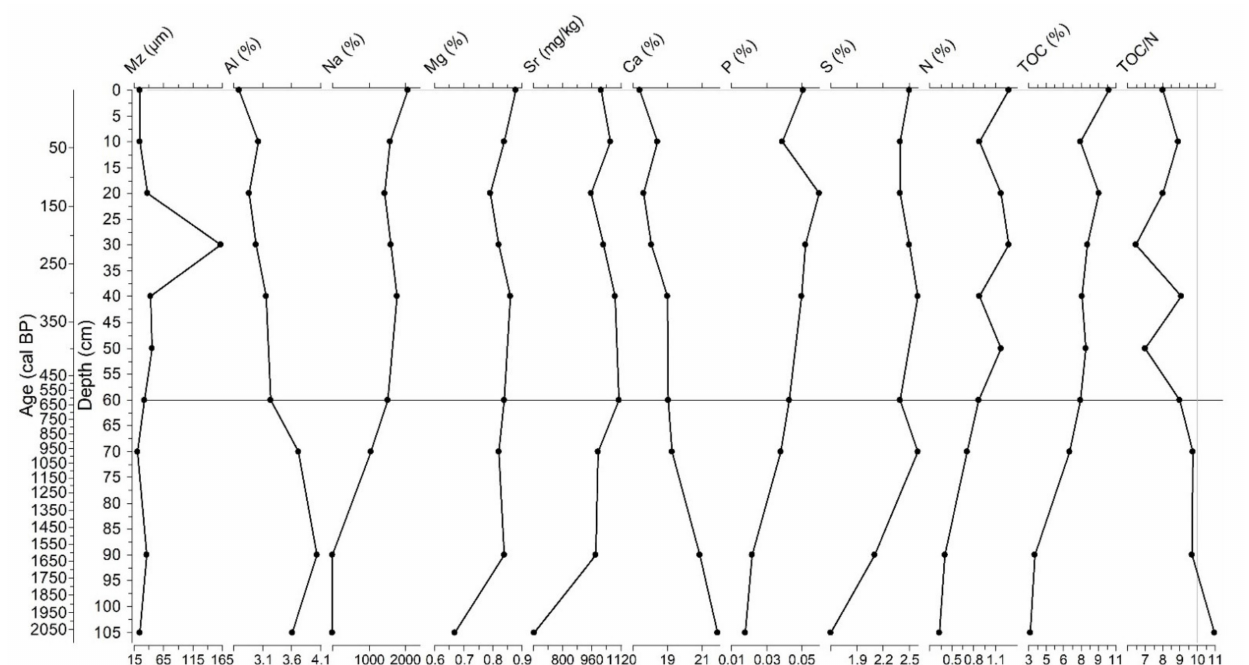
Figure 9. Selected major and trace element concentrations, mean grain size (Mz), and N, TOC, and CN values in the sediment core KB-1/1 from Kolanjsko Blato, with a marked black horizontal line indicating sediment deposition